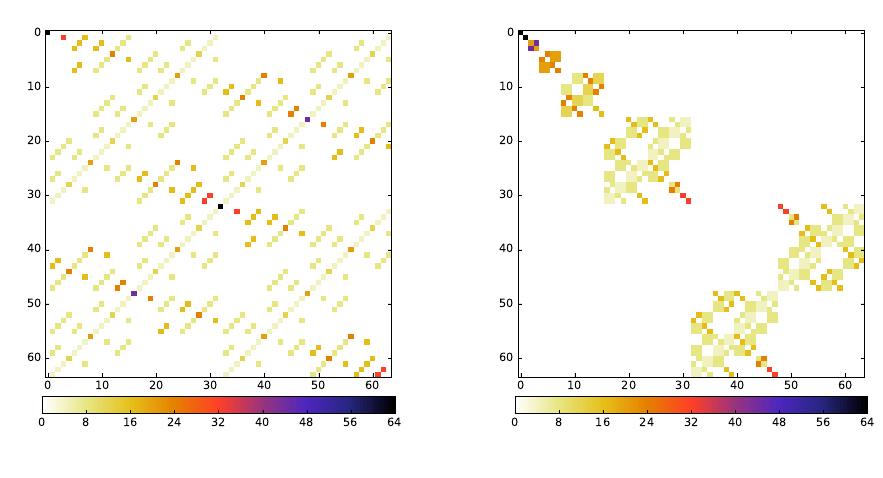
Figure 19: ddt of A 3 : x 7→ 3 x (left) and of x 7→ R (3 × R ( x )) (right), for n =